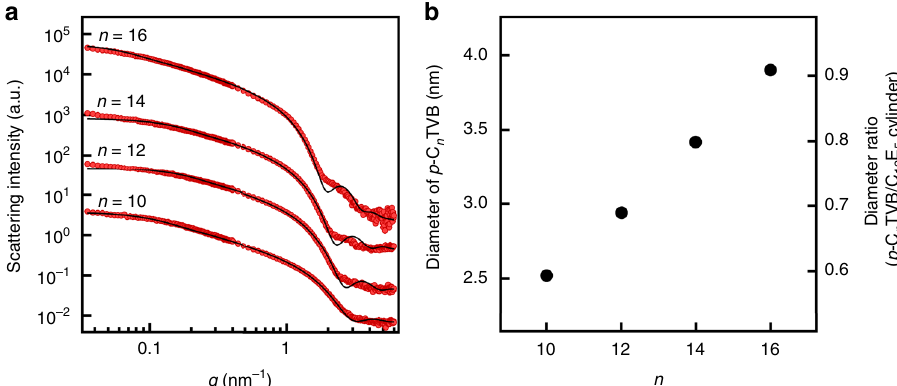
Fig. 1 SANS form factor analysis of p -C n TVB. a SANS intensities of 0.1 wt% p -C n TVB in D 2 O (10 mM NaCl) for n = 10, 12, 14, and 16 ( red ). The black solid lines are model fi ts using a cylindrical particle form factor. n = 10 data are on an absolute scale while other data sets are shifted vertically for visual clarity. b The diameters of p -C n TVB estimated from the model fi ttings and the diameter ratios of p -C n TVB to C 12 E 5